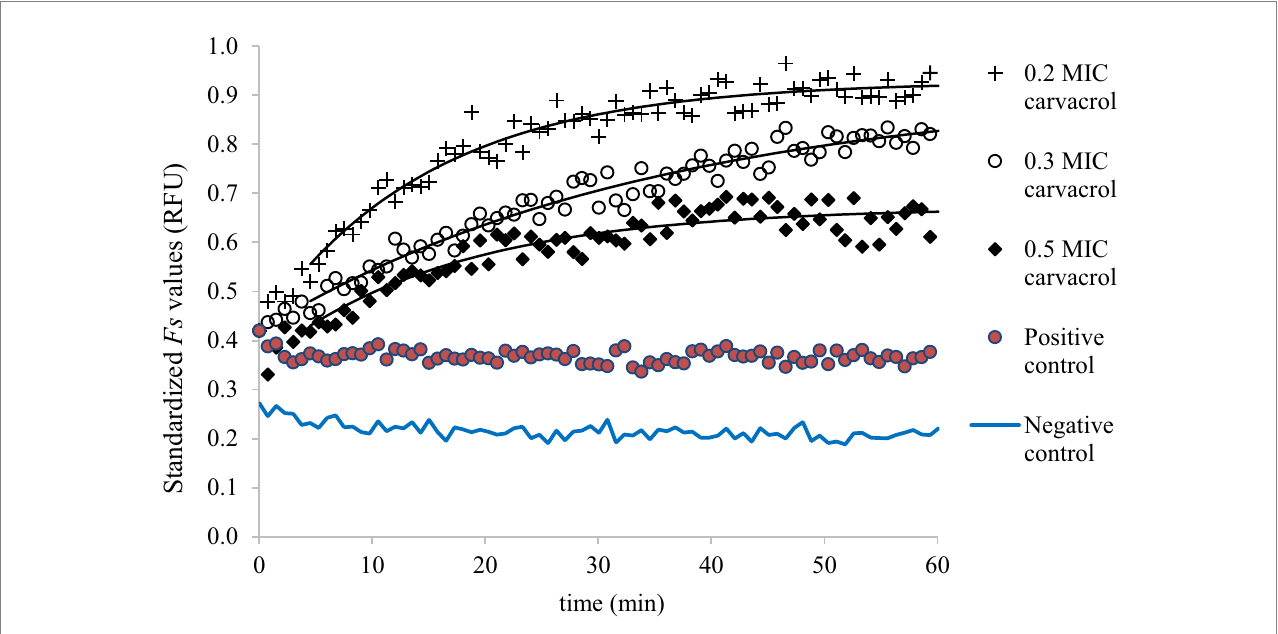
FIGURE 4 Saturation model fitted to the standardized Fs curves, demonstrating the accumulation of EtBr at 0.2, 0.3, and 0.5 MIC carvacrol treatments, in slow- growing culture of E. coli ATCC 11229. As a negative control, the Fs values were measured in uninoculated suspension (in PBS) while the non-treated culture was the positive